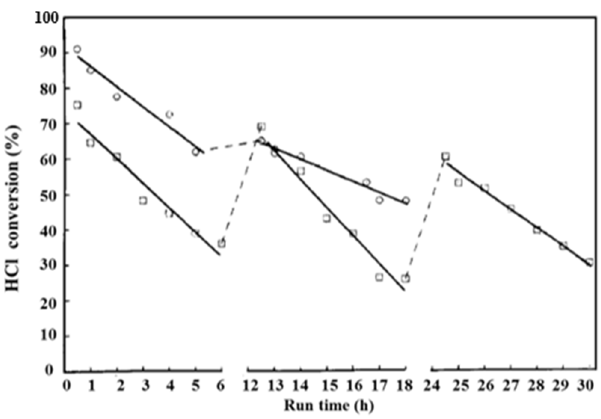
Figure 9. Effect of reactivation of catalyst with HCl treatment; ○ HgCl 2 /C, 9% Hg; □ HAuCl 4 /C, 1.9% Au; (––––) HCl treatment [16].